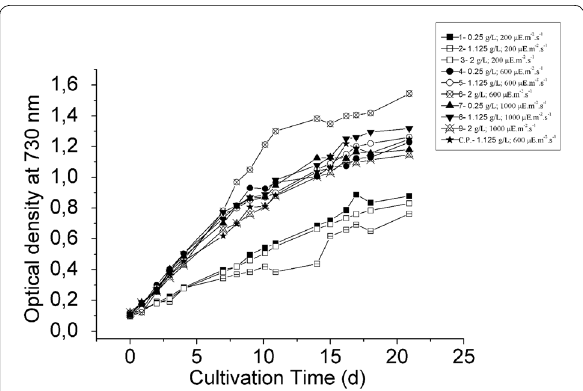
Fig. 1 Growth curves of A. platensis at different conditions of NaNO 3 and PFD. (C. P. refers to central